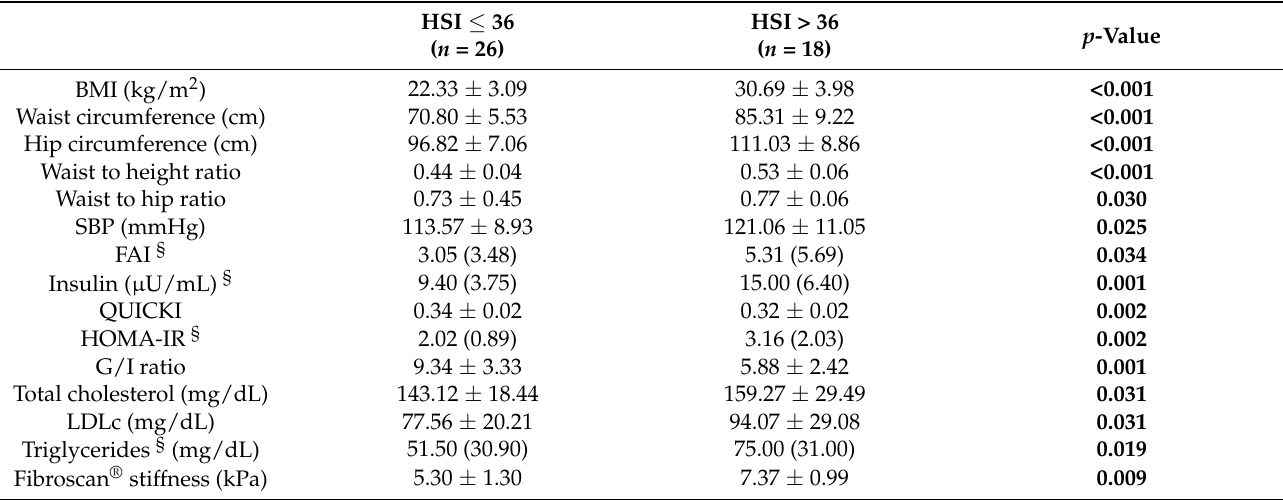
Table 4. Significant differences in anthropometric, biochemical/hormonal parameters, IR, and liver fibrosis indices between PCOS adolescents with or without hepatic